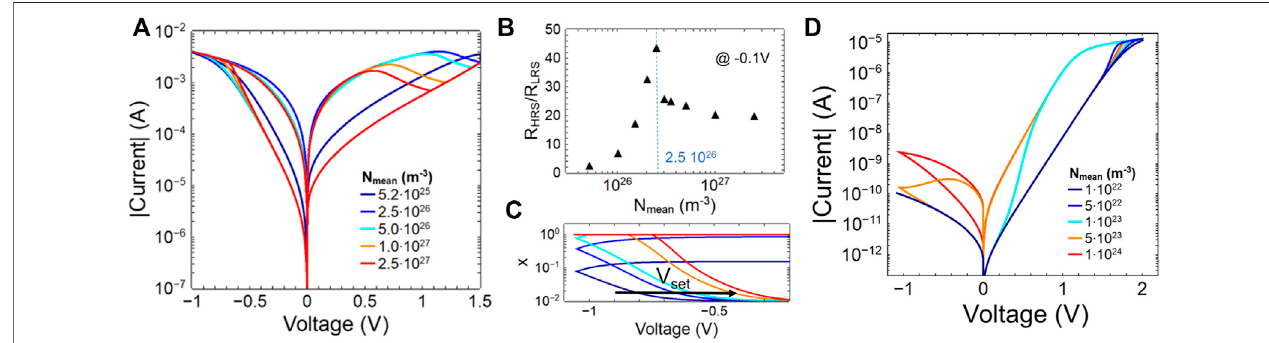
FIGURE6| SimulatedI-VcurvesofTiN/TiO x /HfO x /Aubi-layermemristivedeviceswithavariationofthemeanconcentrationofmobileionsintheHfO x layer. (A) The variationofthemeanconcentrationofpositivelychargedionsintherangefrom5 . 2 · 10 25 m − 3 to2 . 5 · 10 27 m − 3 issimulatedfortypeF. (B) Theratioof R HRS / R LRS at − 0.1 V as a function of the mobile ions. The optimum memristive hysteresis was observed at the mobile ion concentrations of 2 . 5 · 10 26 m − 3 . (C) The state variable ( x ) as a function of the applied voltages for different concentrations of mobile ions in the HfO x layer. Operating voltages (SET/RESET voltage and threshold voltage) in the bi-layer memristive devices were affected by the concentration of mobile ions in the HfO x layer. (D) The variation of the concentration of negatively charged ions in the range from 1 · 10 22 m − 3 to 1 · 10 24 m − 3 is simulated for type R. The resistance values and the hysteretic effects were in fl uenced by the concentration of oxygen ions.